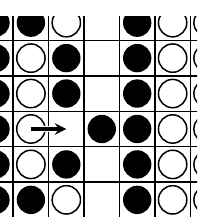
Figure 34. WHITE comes in.